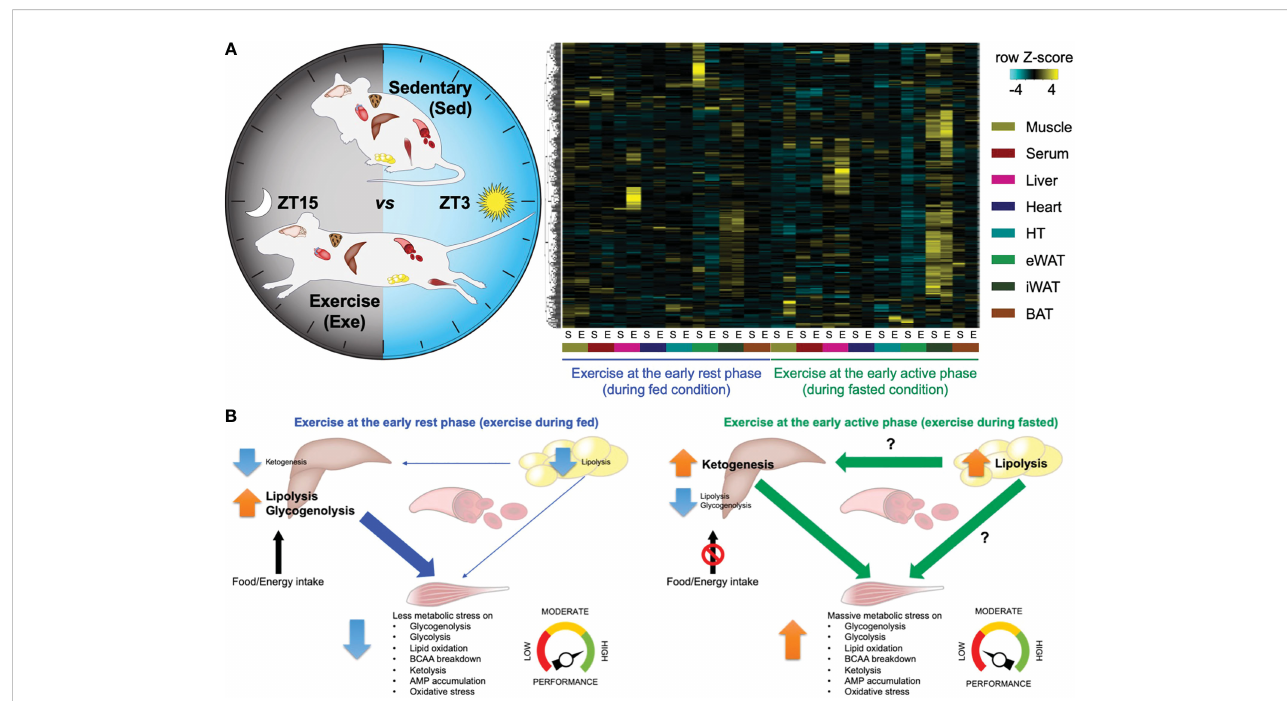
FIGURE 1 – Atlas of exercise metabolism unique to the time of day reveals tissue-dependent and collective metabolic responses to timed exercise (52). (A) Multi- tissue metabolomics upon exercise at the early rest (ZT3) versus the early active phase (ZT15). Heatmap displaying metabolites signi fi cantly changed only in a speci fi c tissue and only after speci fi c timing of exercise. (B) Schematic summary representing time-of-exercise-speci fi city of types of energy and the speci fi c tissue of origin for energy during exercise. This fi gure represents a graphical representation of metabolomics data generated with the author ’ s permission and data from Sato et al., 2022